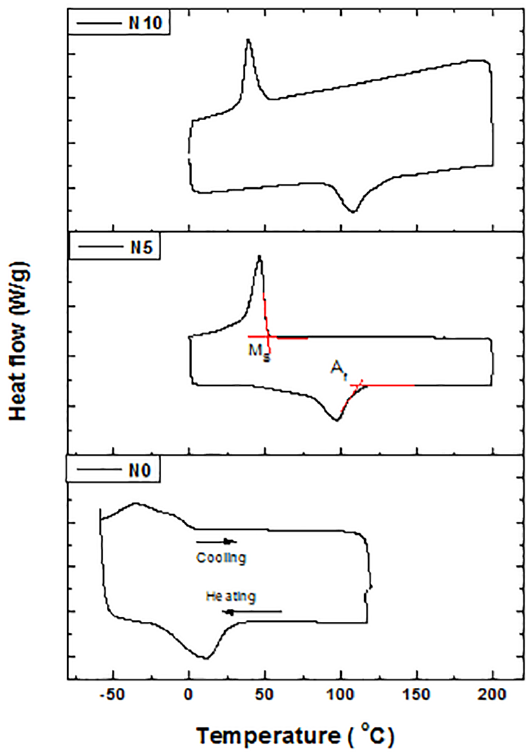
Figure 2. DSC curves of the alloys, N0 alloy (a), N5 alloy (b), N10 alloy (c). The temperatures As and Ms were obtained by the tangent method as shown in the curve of Fig. (b).